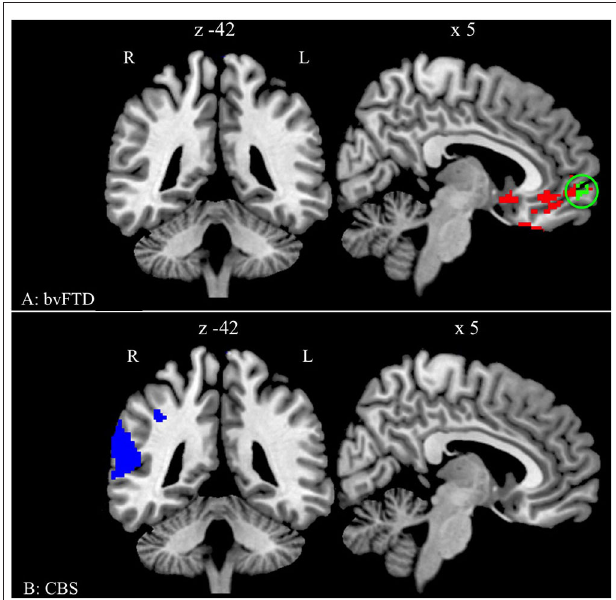
FIGURE 2 | Significant gray matter (GM) atrophy in behavioral variant frontotemporal degeneration (bvFTD) and CBS, and regression analysis relating performance to reduced GM density. (A) Regions of reduced GM density in patients with bvFTD relative to healthy seniors (red and green) and regions related to the adjusted accuracy of ambiguous anaphoric reference in bvFTD patients (green). The green cluster is in the ventromedial prefrontal cortex (vmPFC) (BA 10/11; peak: 2 60 − 8). (B) Regions of reduced GM density in patients with CBS relative to healthy seniors